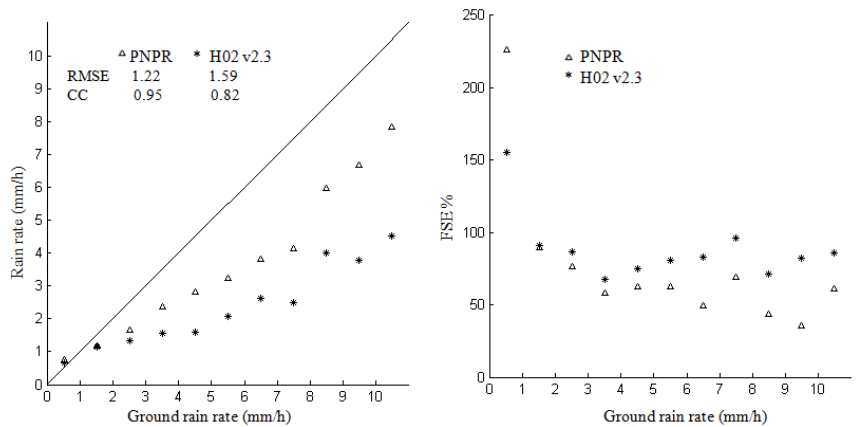
Figure 12. Binned analysis of PNPR and H02 v2.3 retrievals for all case studies. The left panel shows the average retrieved values as a function of the 1mmh − 1 rain rate bins of ground-based measurements. The right panel shows the FSE% values obtained for the retrievals within each bin (see the text for